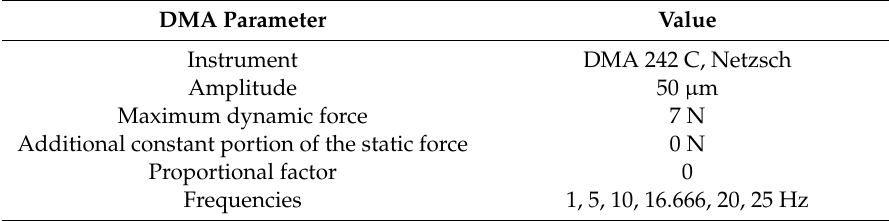
Table 1. Measuring parameters of dynamic mechanical